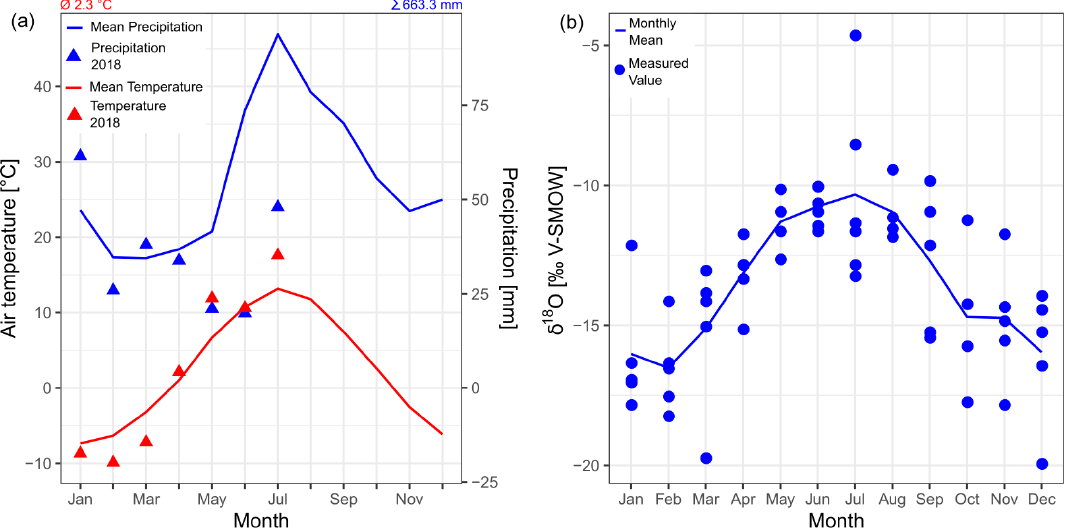
Figure 4. (a) Monthly climatology of air temperature and precipitation in the study area from the meteorological station Mörsil for the period of 1975–2005 (data from SMHI, 2020b). The values of the year 2018 until the time of sampling (July) are indicated by the triangles. The average annual air temperature and the average annual precipitation are given at the top of the plot. (b) δ 18 O in precipitation at the GNIP station Bredkälen for the period of 1975–1980 (data from IAEA/WMO, 2019). See Fig. 2 for the locations of the